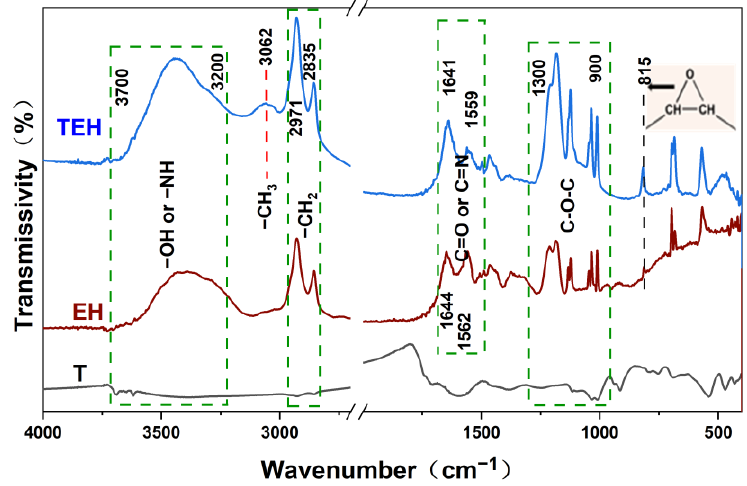
Figure 1. FT-IR spectra of tannin (T), epoxidized soybean oil-hexanediamine (EH) and tannin-epoxidized soybean oil-hexanediamine (TEH) resins.